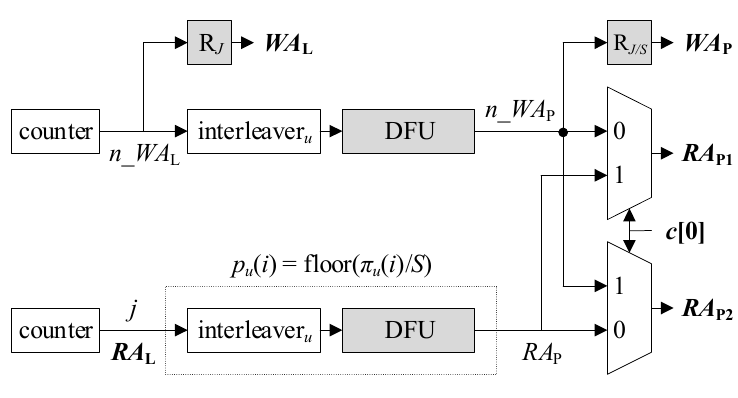
Figure 6. DFU-reduced S-AGU.